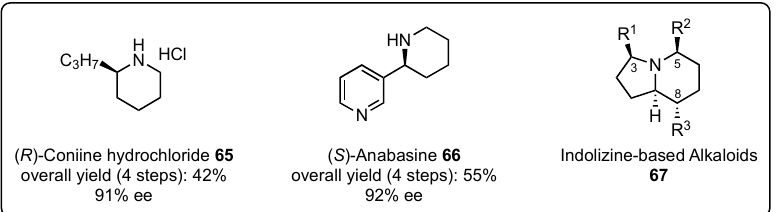
Figure 2. Total synthesis of ( R )-coniine hydrochloride ( 65 ), ( S )-anabasine ( 66 ), and indolizine-based alkaloids ( 67 ) based on initial Brønsted acid organocatalyzed asymmetric VMMnRs by Schneider et al. [52,54,55].